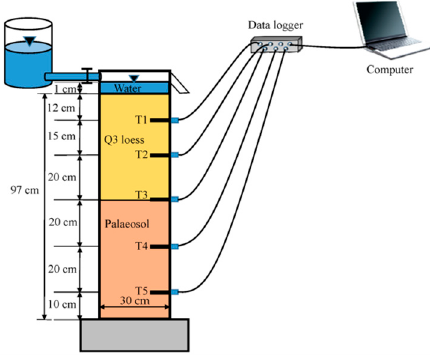
Figure 2. Instruments for the laboratory infiltration experiment.